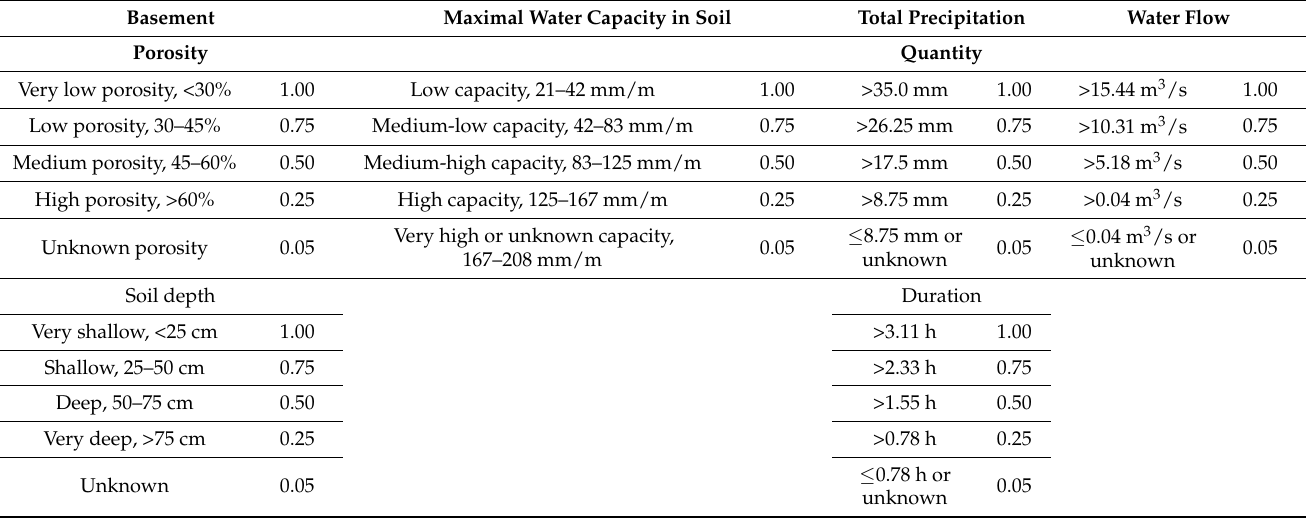
Table 3. Geological–hydrological events presented in four categories with corresponding probabilities.